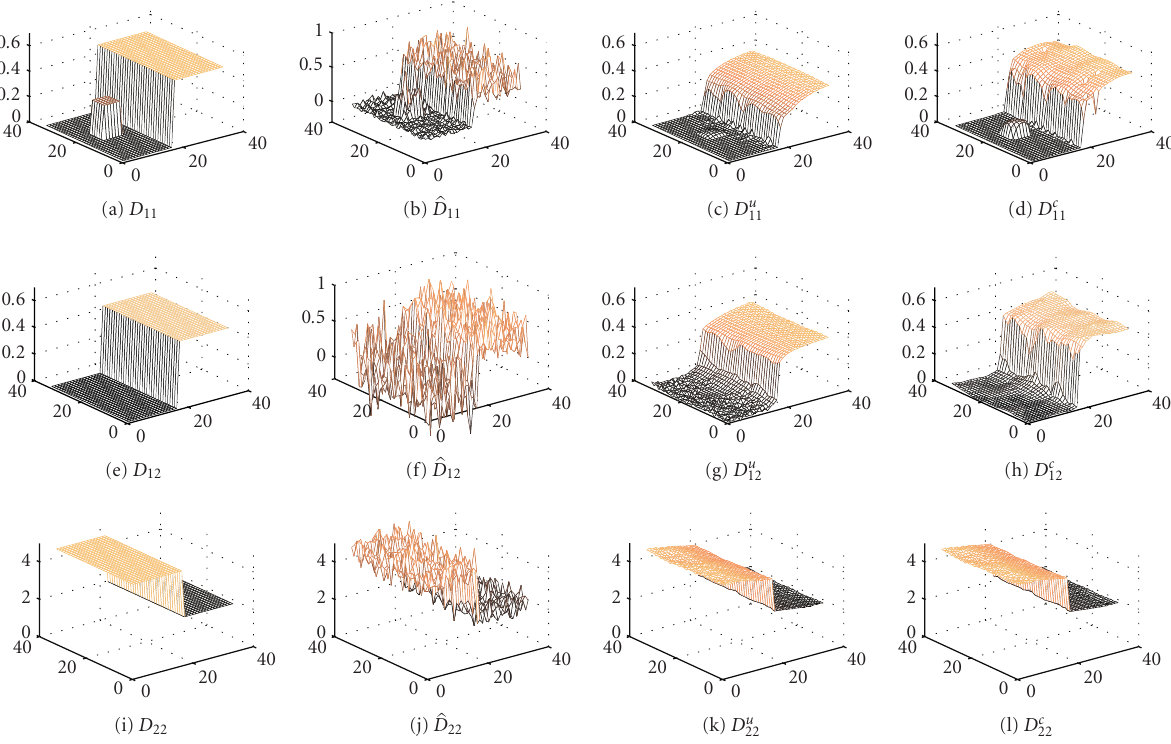
Figure 5: A noisy 2D tensor field is regularized. In this example, the smallest parts of the signal are not easily discriminated from the noise.